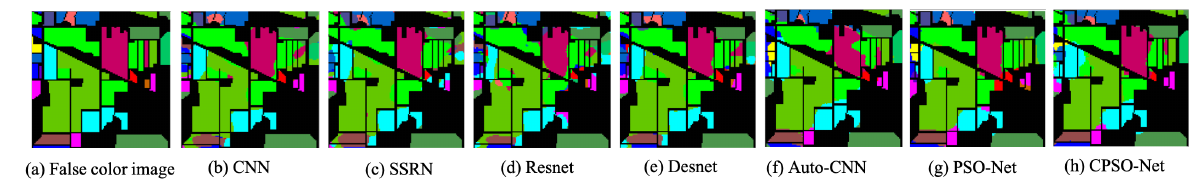
Figure 13. Classification maps based on the biased Salinas dataset.